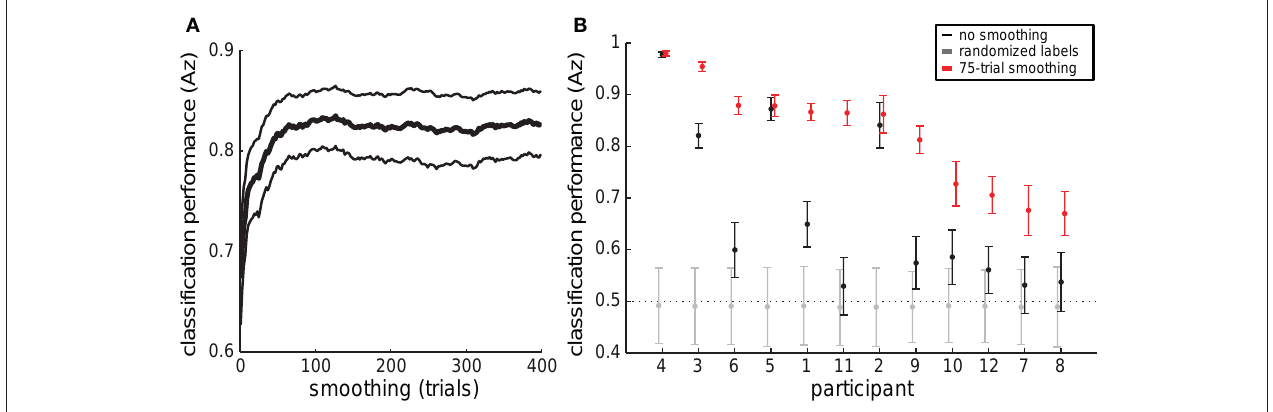
Figure 8 | Single-trial classification of attentional state rating on the basis of prestimulus eeg alpha power. (A) Grand average (thick line) and SE (thin lines) Az score as a function of the degree of smoothing (sliding window size) to the time series of attentional state ratings. (B) Average Az scores and